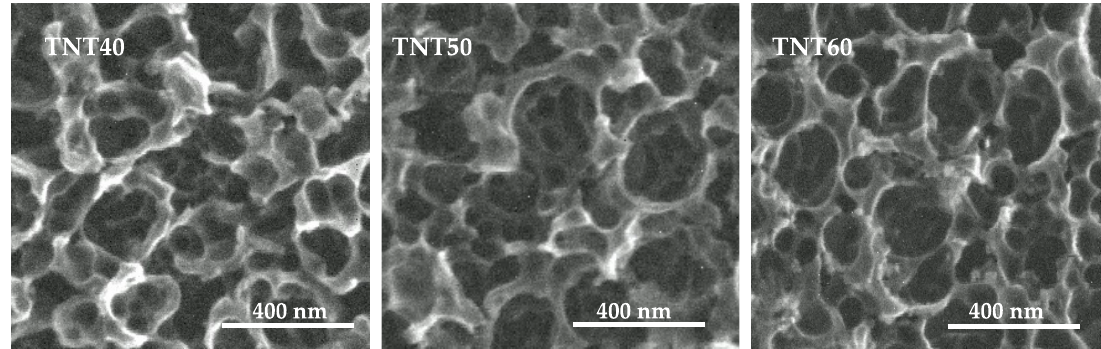
Figure 13. SEM images of TNT40, TNT50, TNT60, which present in detail the inner part of